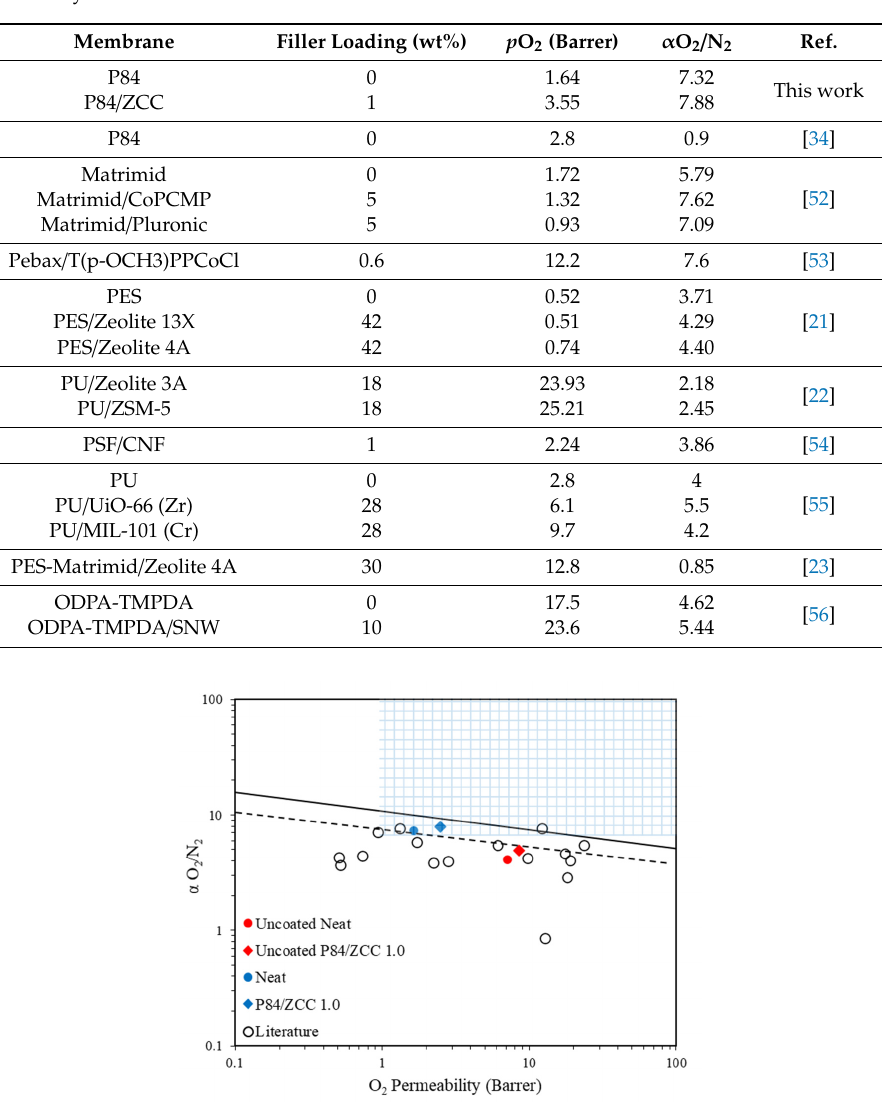
Figure 6. Performance of uncoated PDMS (red), coated membrane (blue) and other membranes from the literature with respect to the Robeson upper bounds.